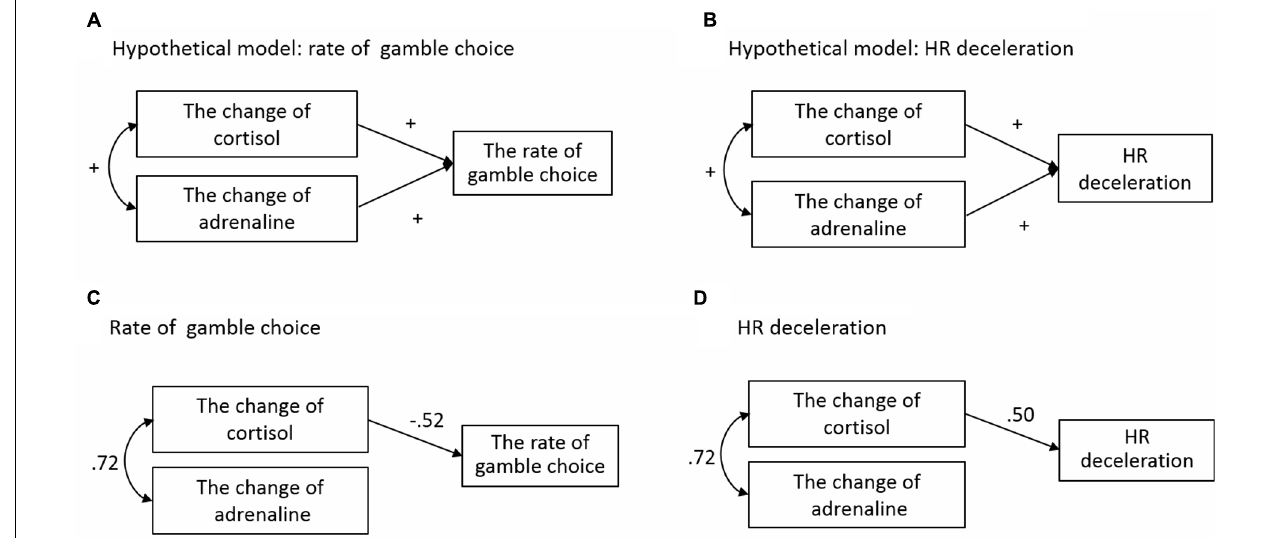
FIGURE 8 | Structural equation modeling for rates of gamble choice and HR deceleration. (A) The hypothetical model for rate of gamble choice. (B) The hypothetical model for HR deceleration. (C) The result of SEM for rate of gamble choice. (D) The result of SEM for HR